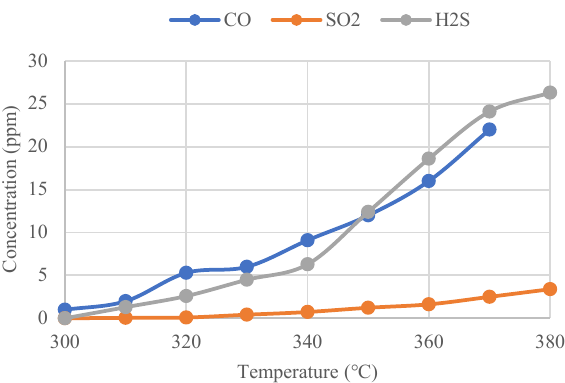
Figure 2. CO, SO 2 and H 2 S concentrations as a function of